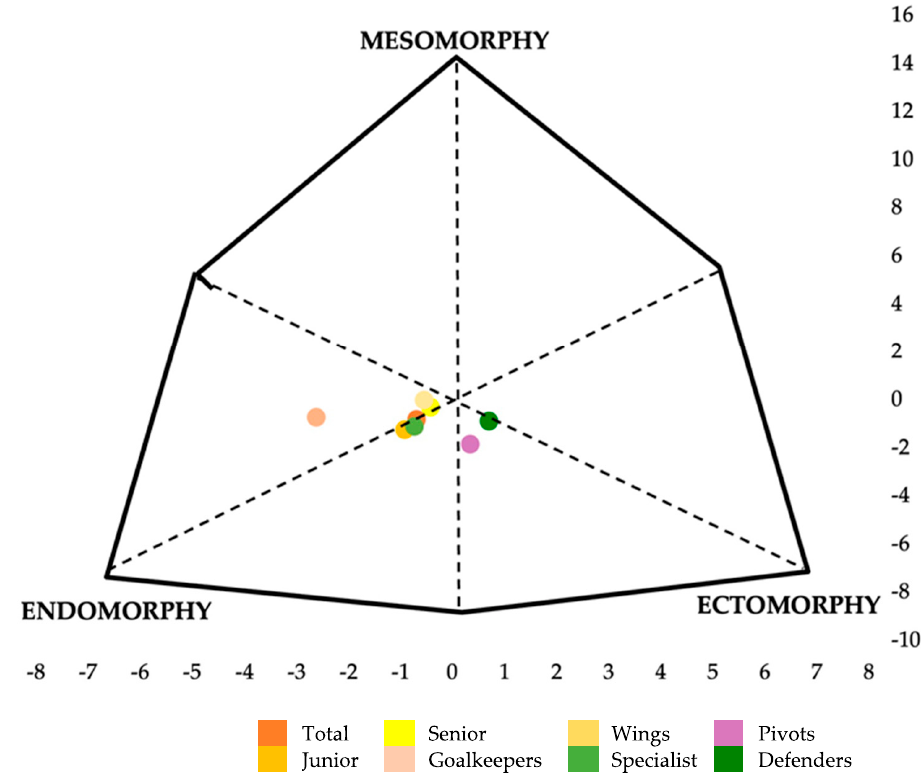
Figure 1. Somatotype distribution in elite female beach handball players.